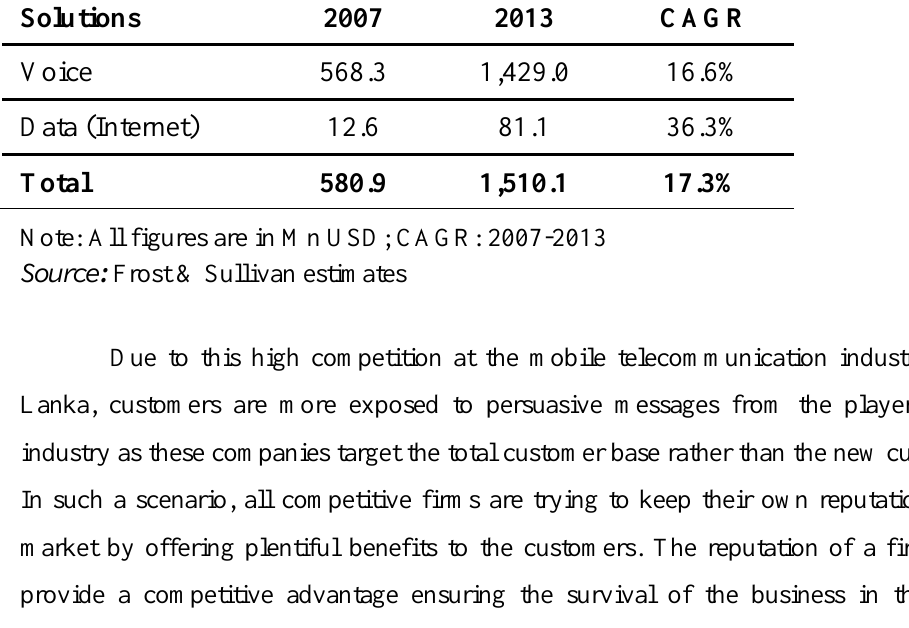
Table 2: Growth in consumer market